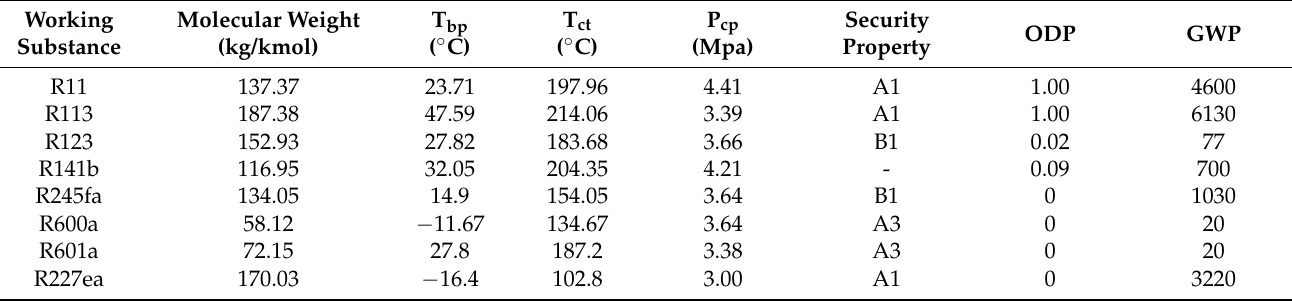
Table 3. Physical parameters table of organic working fluids